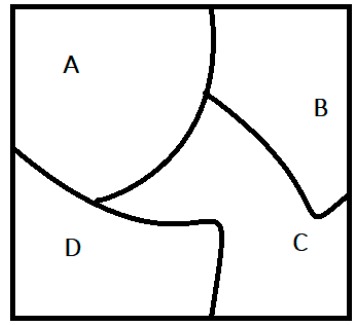
Figure 1. Graphical representation of a 10 × 10 EEA (Experimental Ecosystem Accounting) reference grid cell that includes four different ecosystem types, i.e., A, B, C, D. By this, the normalized, relative area of each MAES level 2 ecosystem type [32] is calculated in each grid cell, with respect to the total area extent of the given ecosystem type in each floristic region of Greece [29,33] and all cells are scored in a common scale (0 to 1). In the present study, we followed this